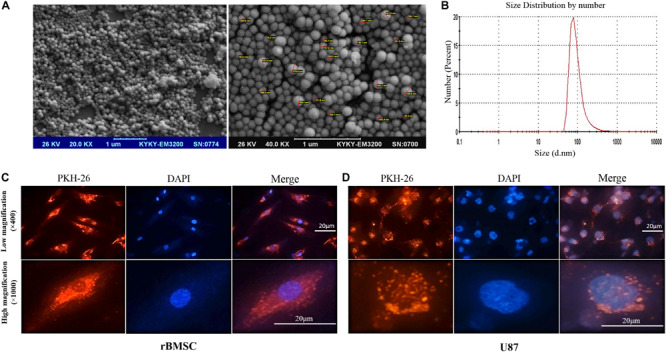
Characterizing exosomes and their internalization. (A) Scanning electron microscopy (SEM) analysis (magnifications of 20,000× and 40,000×) of exosomes demonstrated a spherical morphology for the isolated vesicles with a size range of 30 to 171 nm in diameter. (B) Dynamic light scattering image from isolated exosomes indicated a peak size at approximately 80 nm. (C,D) Internalization of cell-derived exosomes into U87 cells was confirmed via staining exosomes’ membrane with PKH-26 (showed in red). U87 cell nuclei staining is also evident by staining the cells with DAPI (showed in blue). Red fluorescence in the cytoplasm of the rat bone marrow stem cells and U87 cells indicated that significant amounts of the labeled exosomes were taken up by the cells.